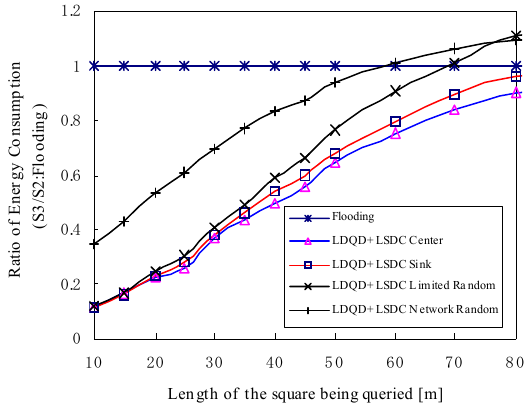
Figure 6 . Ratio of energy consumption for approaches using S2 and S3